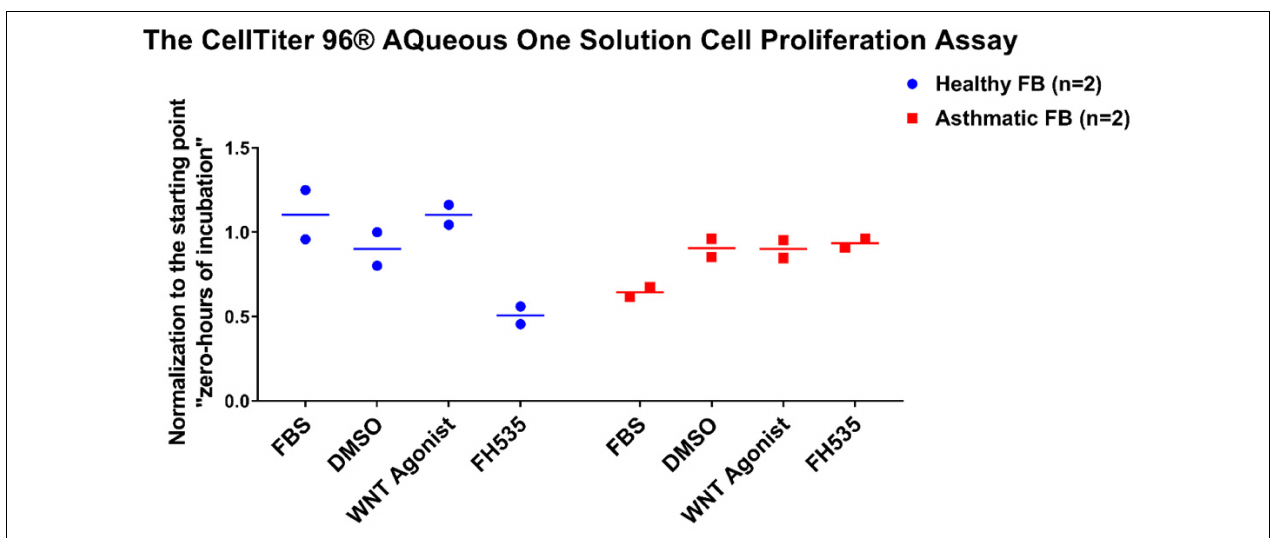
FIGURE 13 | Fibroblast cell proliferation under the effect of Wnt signaling activation or inhibition. Cells were seeded in triplicate at a density of 10,000 cells/well in opaque 96-well plates for 24 h. The CellTiter 96 R (cid:13) Aqueous One solution cell proliferation assay was used to measure the viability of healthy and fibroblasts from asthmatic patients after 24 h of treatment with selective Wnt agonist and FH535, a small-molecule inhibitor of β -catenin/TCF/LEF. The 24-h values were normalized to their corresponding starting value (0-h incubation).